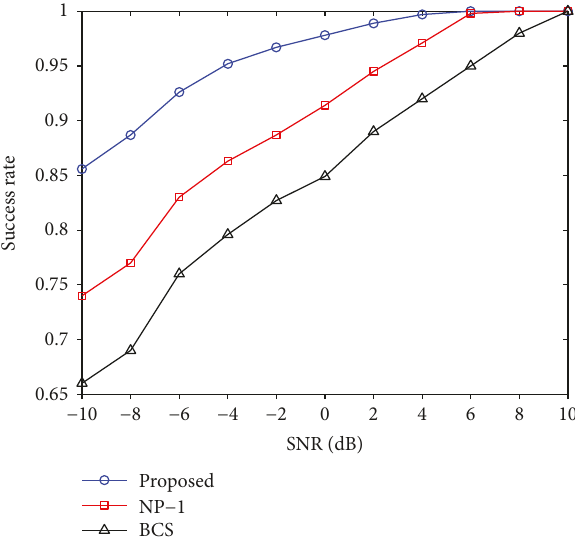
Figure 5: Success rates versus SNR with the fi xed number of snapshots